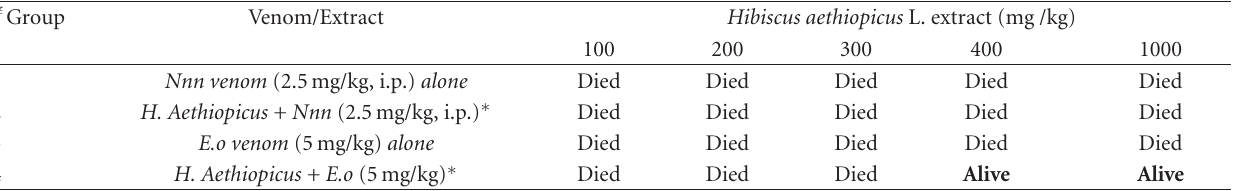
Table 3: Animal status after 30 minutes prior to venom injection.